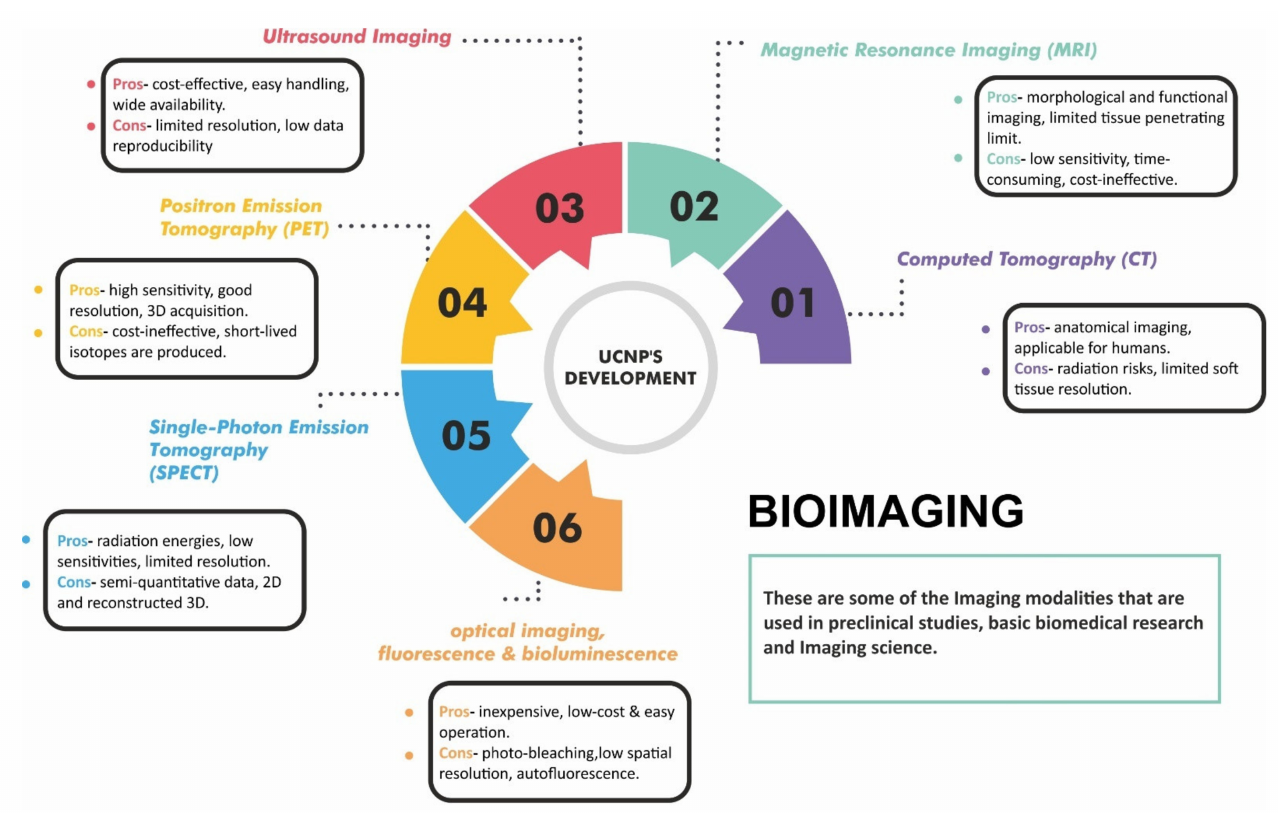
Figure 6. Development of UCNPs in imaging